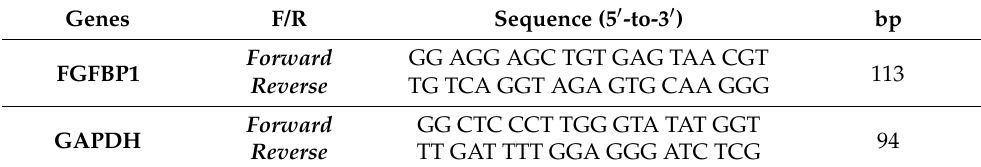
FGFBP1 stands for fibroblast growth factor binding protein 1; GAPDH stands for glyceraldehyde-3-phosphate- dehydrogenase; bp indicates base